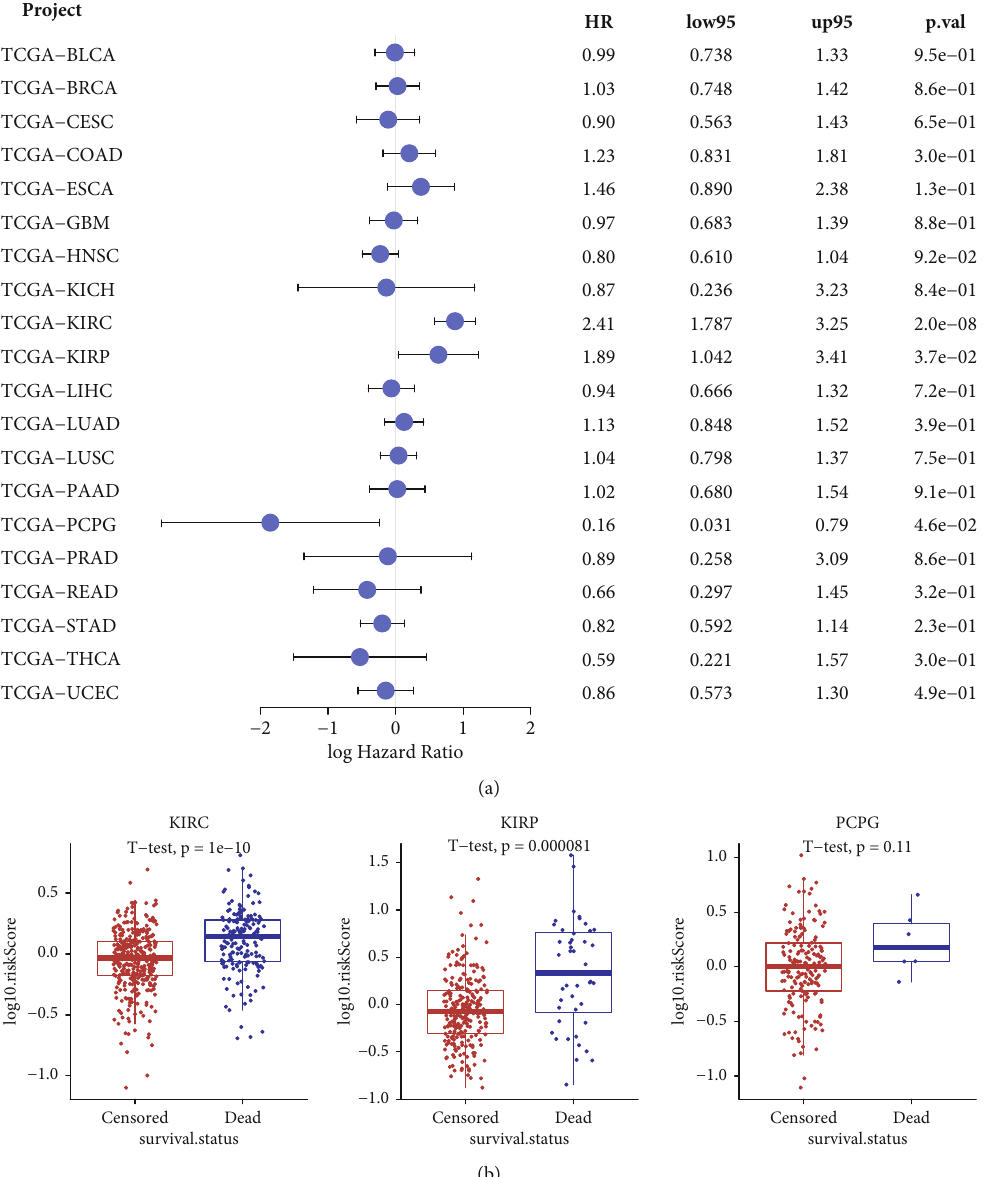
(Figure 6(a)). In KIRP, activated CD4 T cells but not